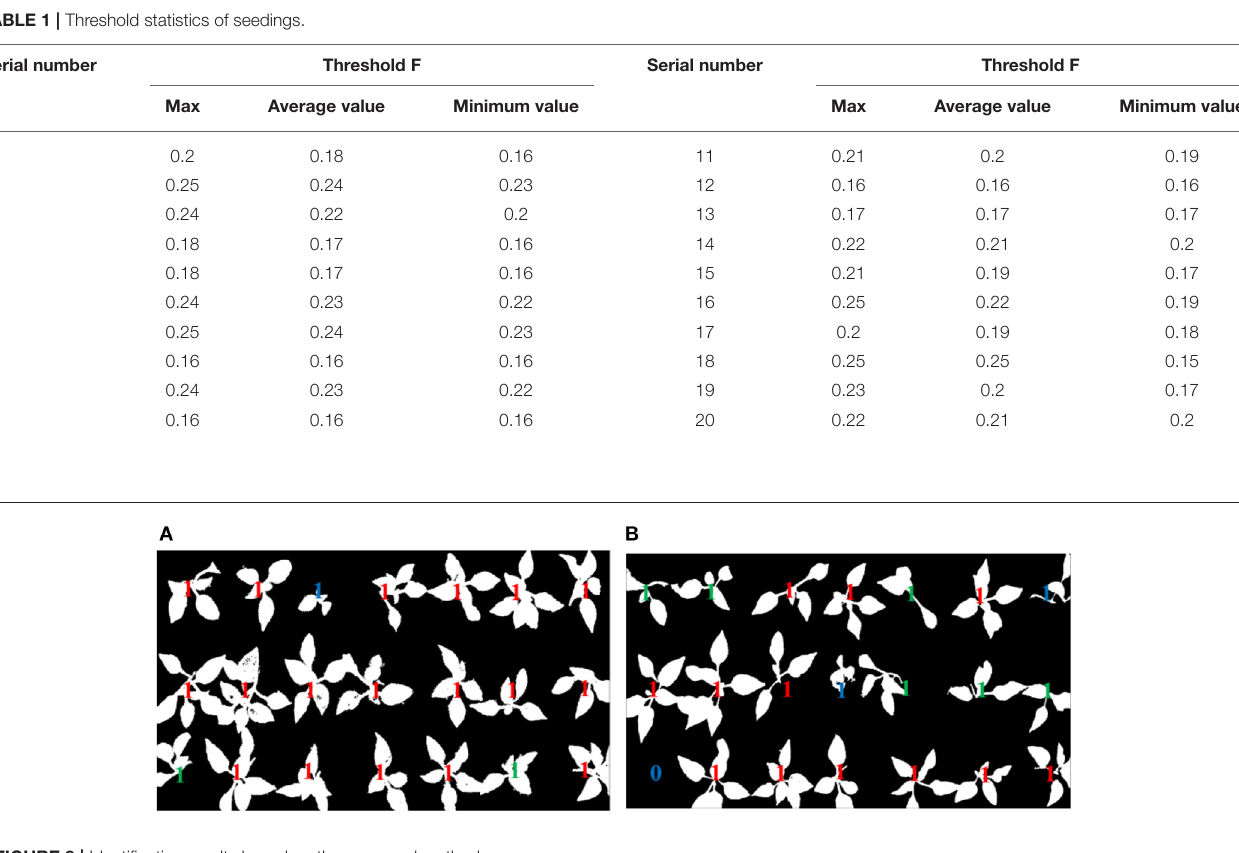
Frontiers in Plant Science |